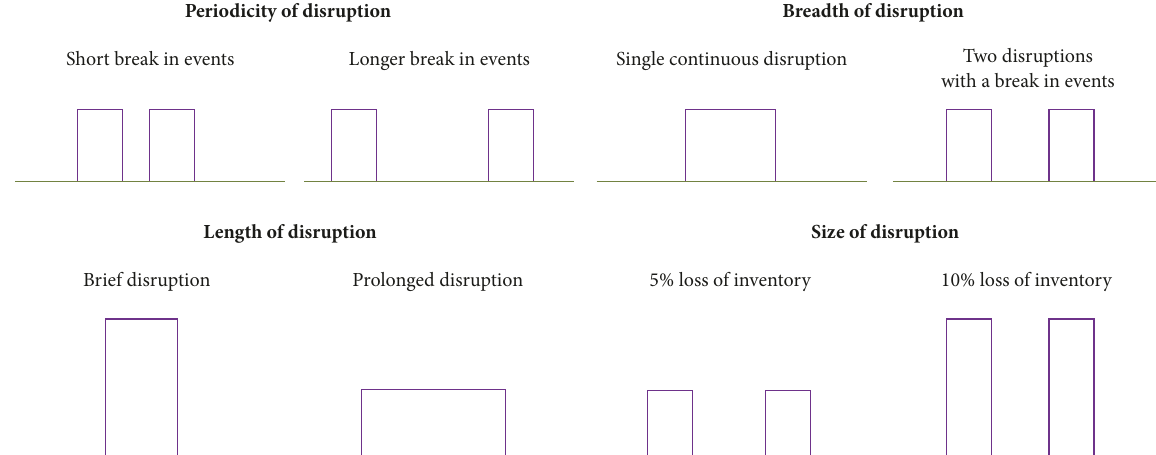
Figure 1: Graphical description of elements characterizing disruptions including the periodicity, breadth, length, and size.